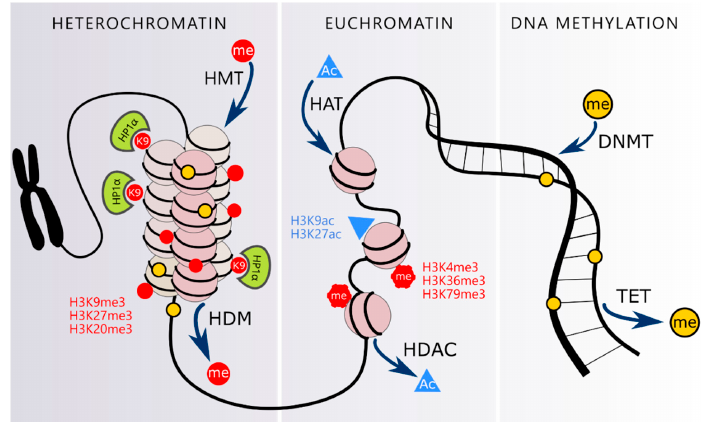
Figure 2. Epigenetic mechanisms shaping chromatin. Chromatin structure is precisely controlled by DNA methylation and post-translational modifications (PTMs; methylation, acetylation, etc.) deposited onto histone tails. Incorporation of methyl and acetyl group is guided by histone methyltransferases (HMTs) and histone acetyltransferases (HATs), while removal of these residues is achieved by histone demethylases (HDMs) and histone deacetylases (HDACs and Sirtuins). The action of these enzymes determines chromatin arrangement and a ff ects gene transcription. Chromatin can adopt two distinct conformations, i.e., heterochromatin and euchromatin. Heterochromatin is a condensed and transcriptionally inactive structure, maintained mainly by methylation of lysine residues. Typical modifications include H3K27me3, H3K20me3 and H3K9me3. Euchromatin represents an open